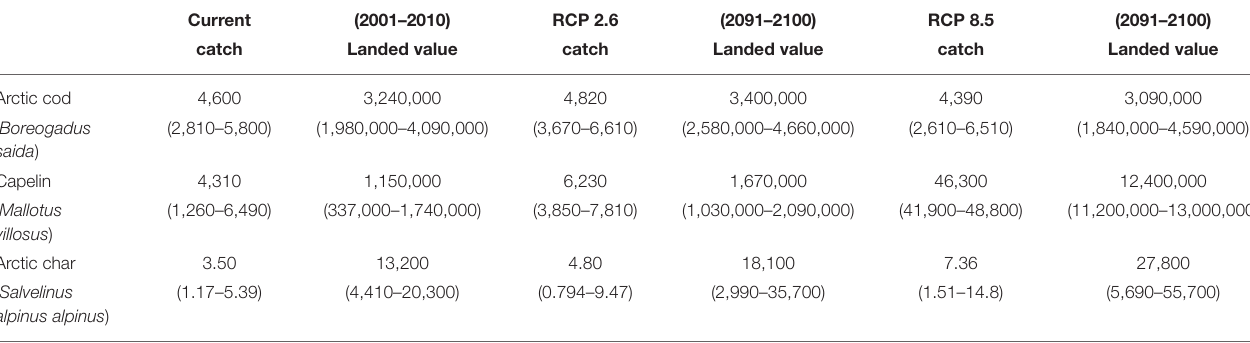
TABLE 3 | Examples for estimates of catch (tonnes) and landed value (USD) of potential current fisheries and future projections under RCP 2.6 and 8.5 scenarios in the Beaufort